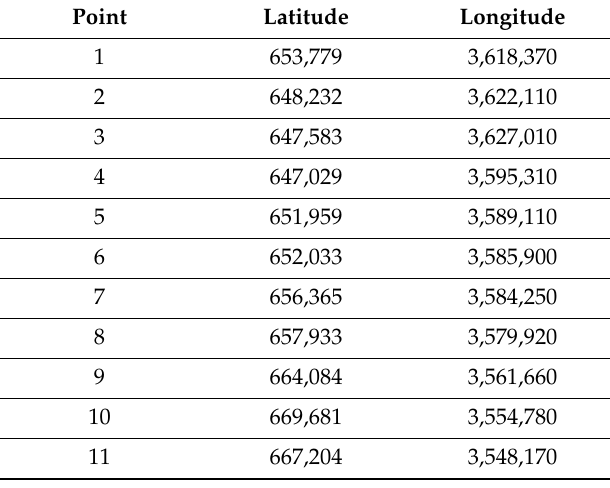
Table 2. Proposed RWH sites